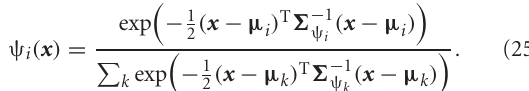
six variables described below: the center position of the battery pack (extracted pixels) in the image plane ( x cx , x cy ), average of absolute values around the center in horizontal and vertical